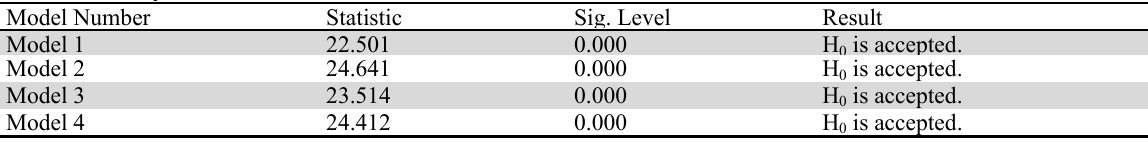
The Summary of F- Lamer